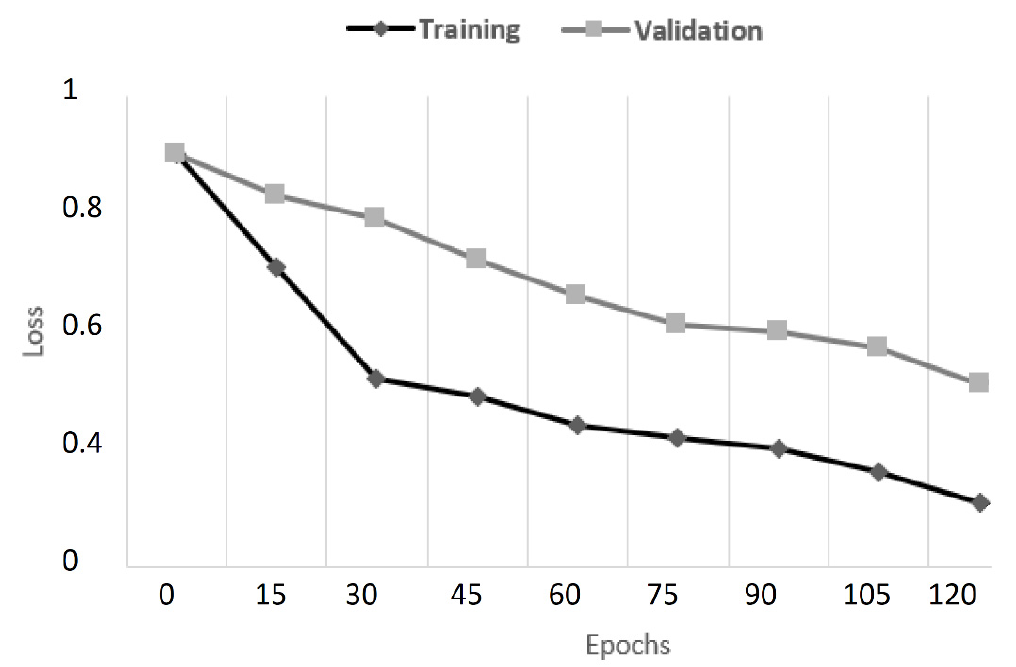
Figure 9. Performance indicators.